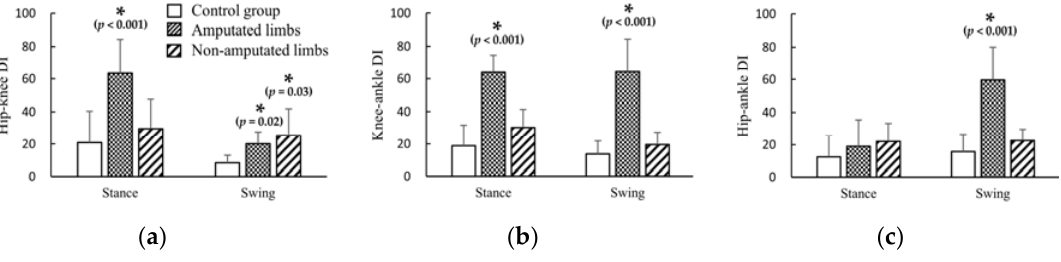
Figure 6. Comparison of the decomposition index (DI): ( a ) hip–knee, ( b ) knee–ankle, ( c ) hip–ankle. * indicates a significant difference compared to the control group.